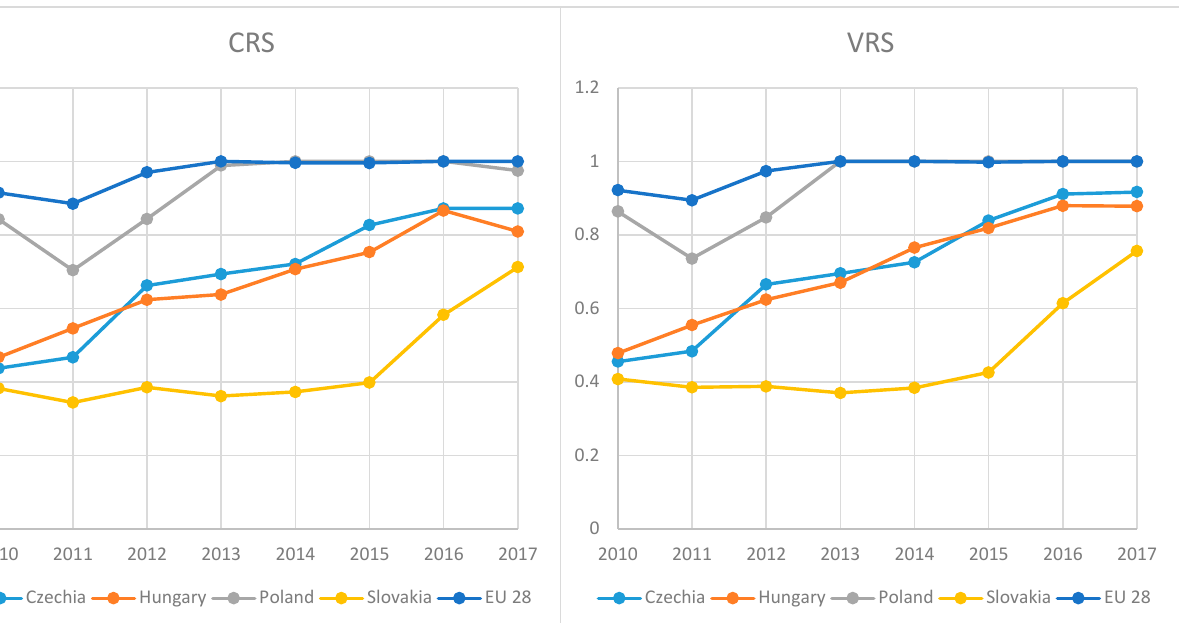
Figure 2. Circular efficiency results of V4 countries.